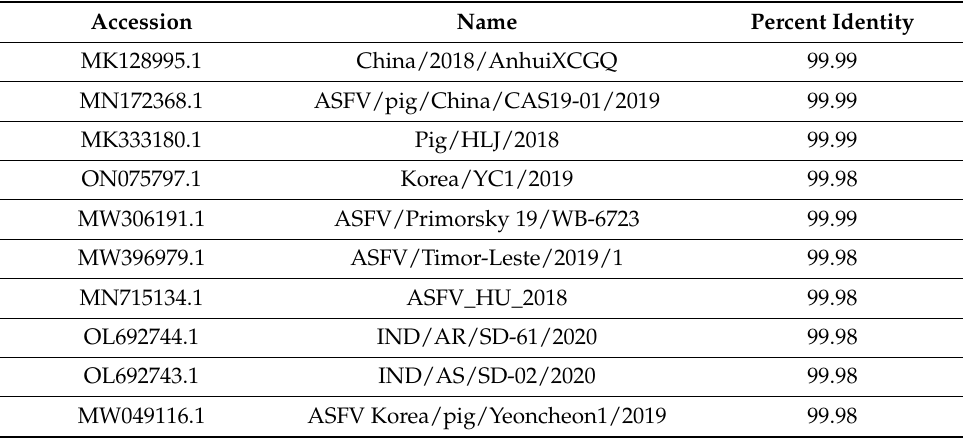
Table 1. The ten sequences with the highest similarity to